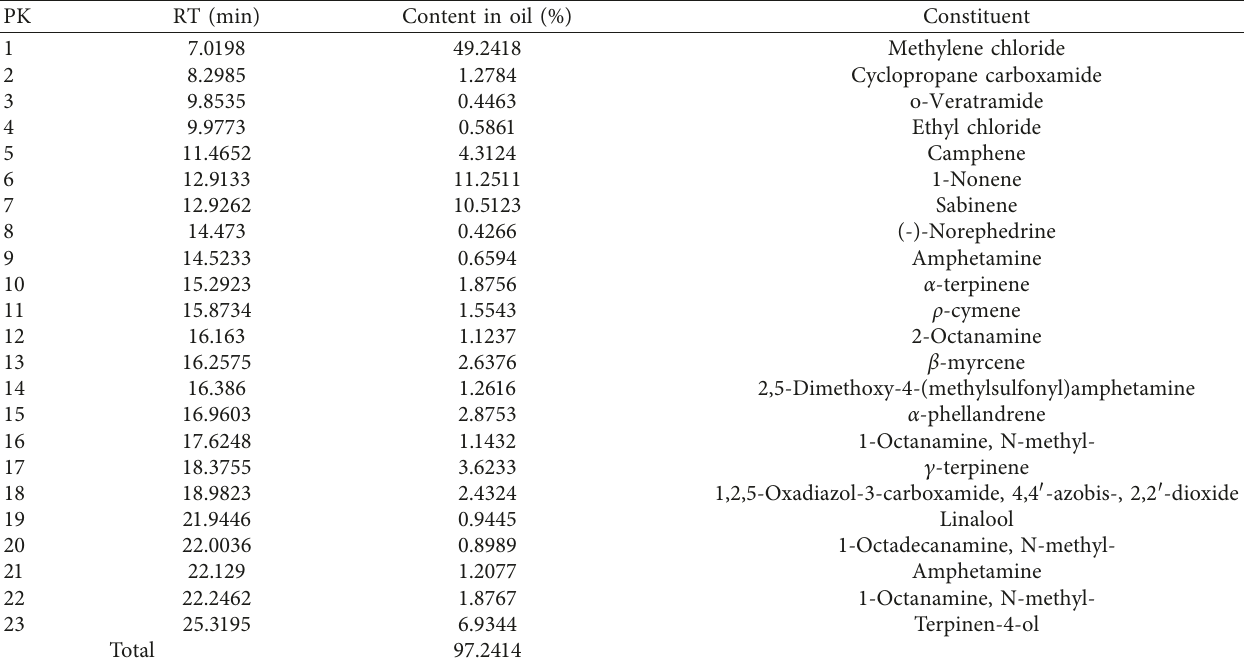
Table 3: The constituents of the EO of S . gigas stem